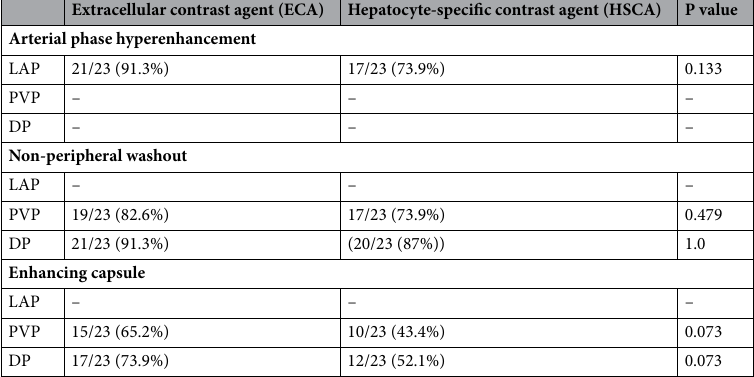
Table 3. Major imaging features of LI-RADS v2018 including arterial phase hyperenhancement, non- peripheral wash-out and enhancing capsule for both contrast agents and throughout the different perfusion phases. LAP late arterial phase, PVP portal venous phase, DP delayed phase.